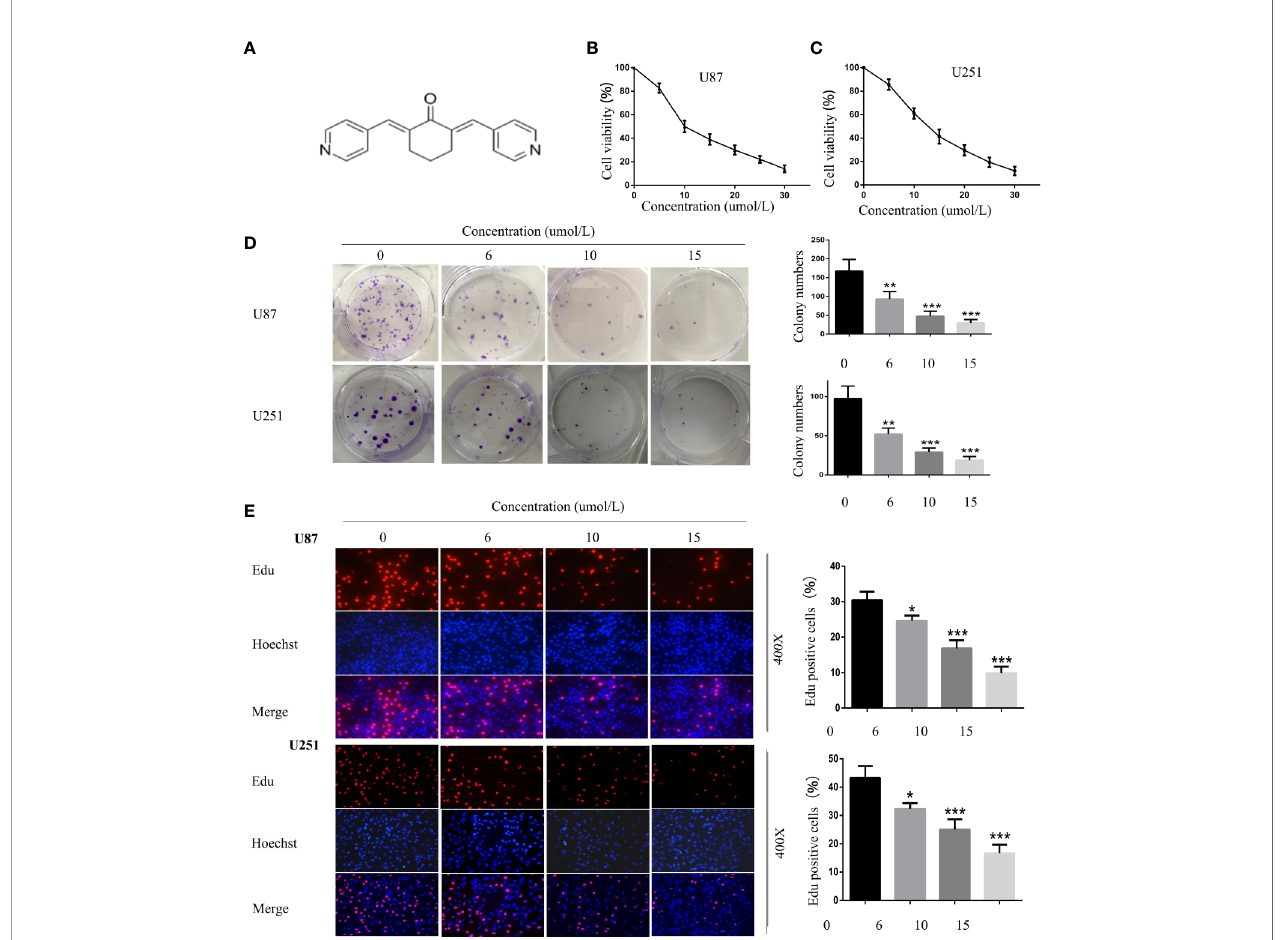
FIGURE 1 | SC66 inhibited the proliferation of GBM cells in vitro . (A) The molecular structure of SC66. (B, C) Cell viability was measured by CCK8 assay after SCC66 treatment with at various concentrations (0, 5, 10, 15, 20, 25, 30 umol/L). (D) SC66 inhibited U87 and U251 cells colony formation and results were statistically analyzed. (E) EDU assay shown that SC66 inhibited DNA synthesis in U251 and U87 cells. For at least three independent experiments. *P < 0.05, **P < 0.01, ***P <